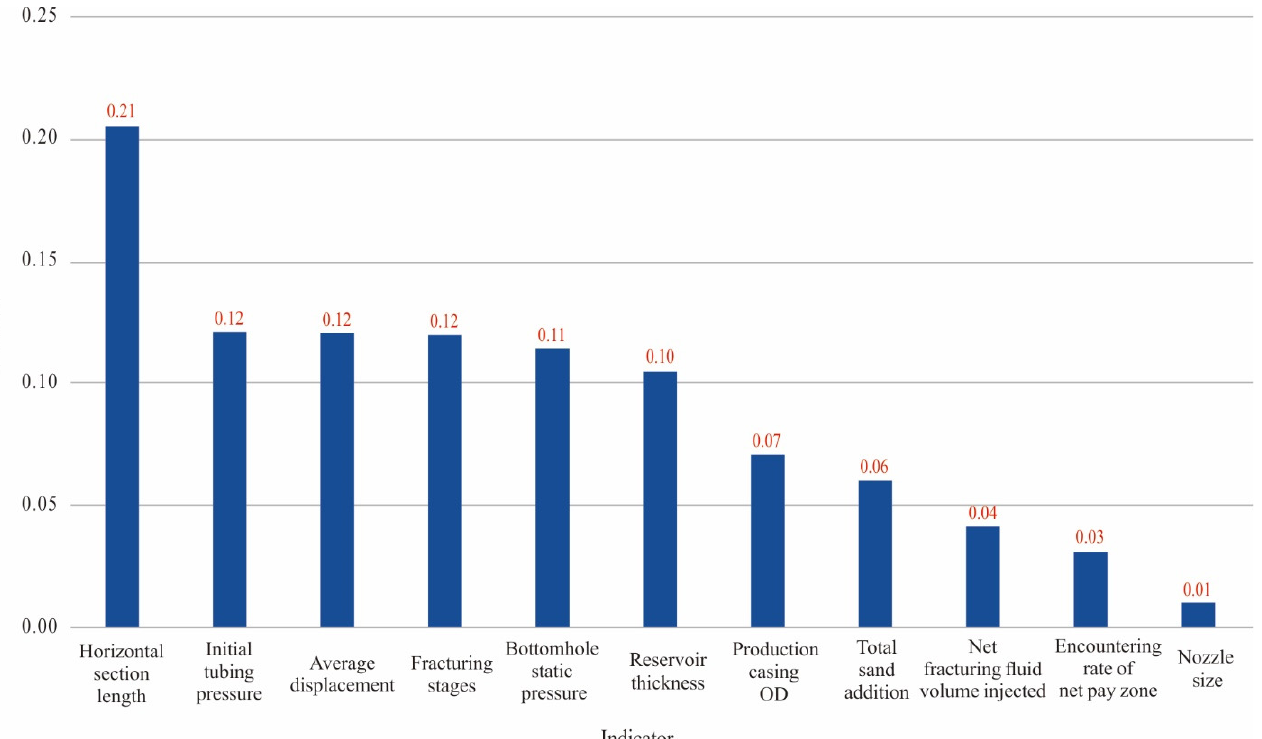
Table 6. Weights of CPII indicators for fractured horizontal wells.